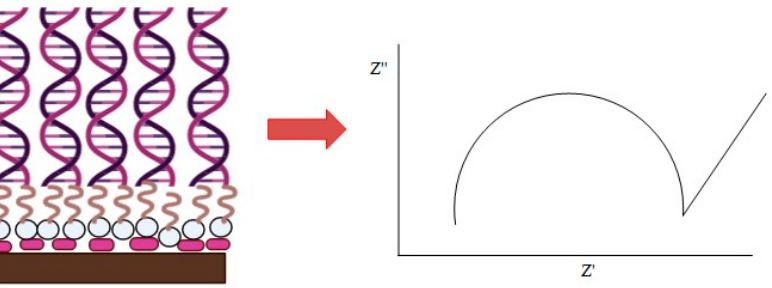
Figure 1. The fabrication of the label-free DNA biosensor, consisting of supported gold nanoparticles (AuNPs), hollow silica microspheres (HSMs), and the E. coli DNA probe for the detection of the E. coli